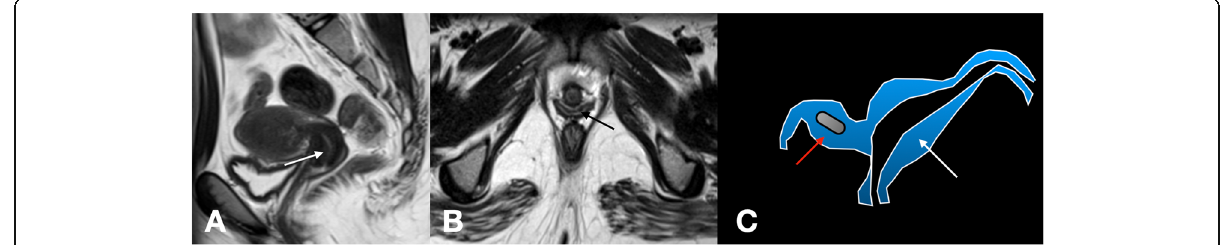
Fig. 2 a – c Sagittal ( a ) and axial ( b ) T2 images showing normal cervix (white arrow) and normal vagina (black arrow). Illustration of our case ( c ) showing hemiuterus (white arrow) and functional non-communicating horn with hematometra (red